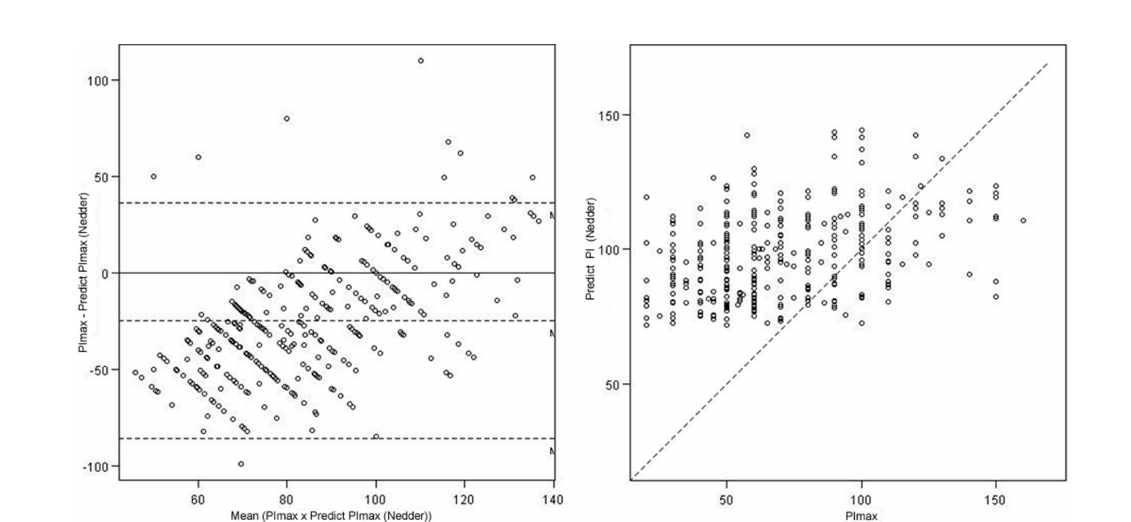
Fig. 2 - Bland-Altman plot and Lin's concordance coefficient of maximal inspiratory pressure (MIP) values predicted by the formula of Neder et al. Confidence interval 95% (0.14 – 0.25); Lin coefficient (0.19)